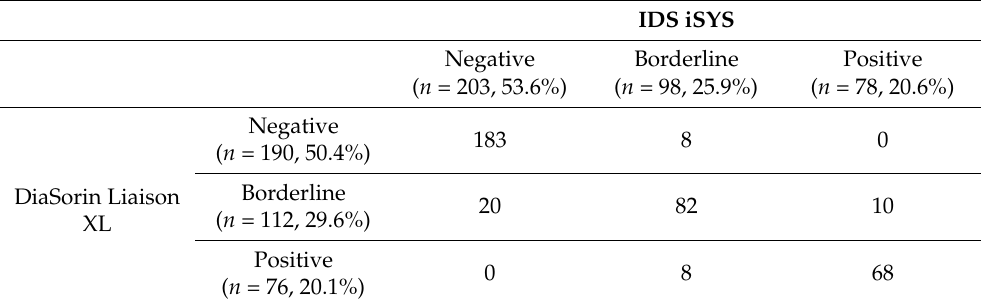
Table 2. Classification of patients according to the recommended 50–120 µ g/g cut-offs. IDS iSYS Negative Borderline Positive ( n = 203, 53.6%) ( n = 59, 15.6%) ( n = 117, 30.9%) Negative 183 9 0 ( n = 192, 50.7%) Borderline DiaSorin Liaison 19 44 10 ( n = 73, 19.3%) XL Positive 1 6 ( n = 114, 30.1%)